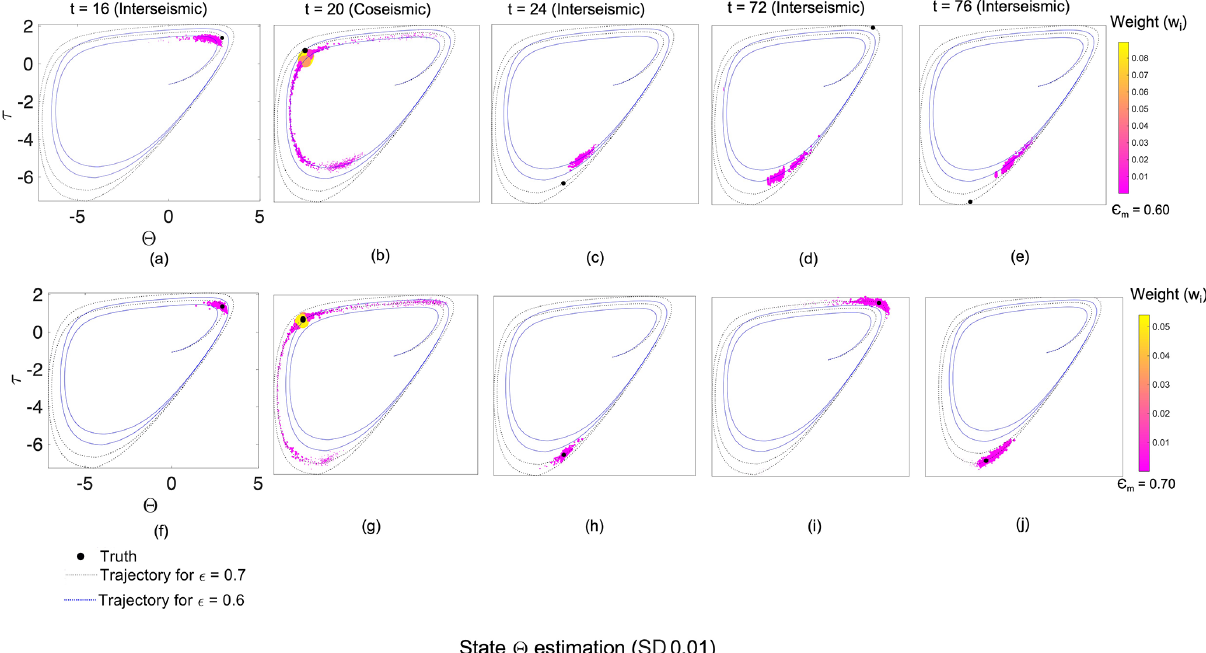
Figure 6. Particles in the (cid:50) – τ space for the case of state estimation with (a–e) intermediate bias ( (cid:15) m = 0.6) and (f–j) no bias ( (cid:15) m = (cid:15) t = 0.7). The points represent the particles in the distribution and the lines represent the trajectories in the phase diagram for the respective values of the parameter (cid:15) m . The blue line represents the phase diagram for (cid:15) m = 0.6, whereas the black line is for the case in which (cid:15) t = 0.7. The sizes and colors of the symbols representing the particles reflect the weight of each particle.